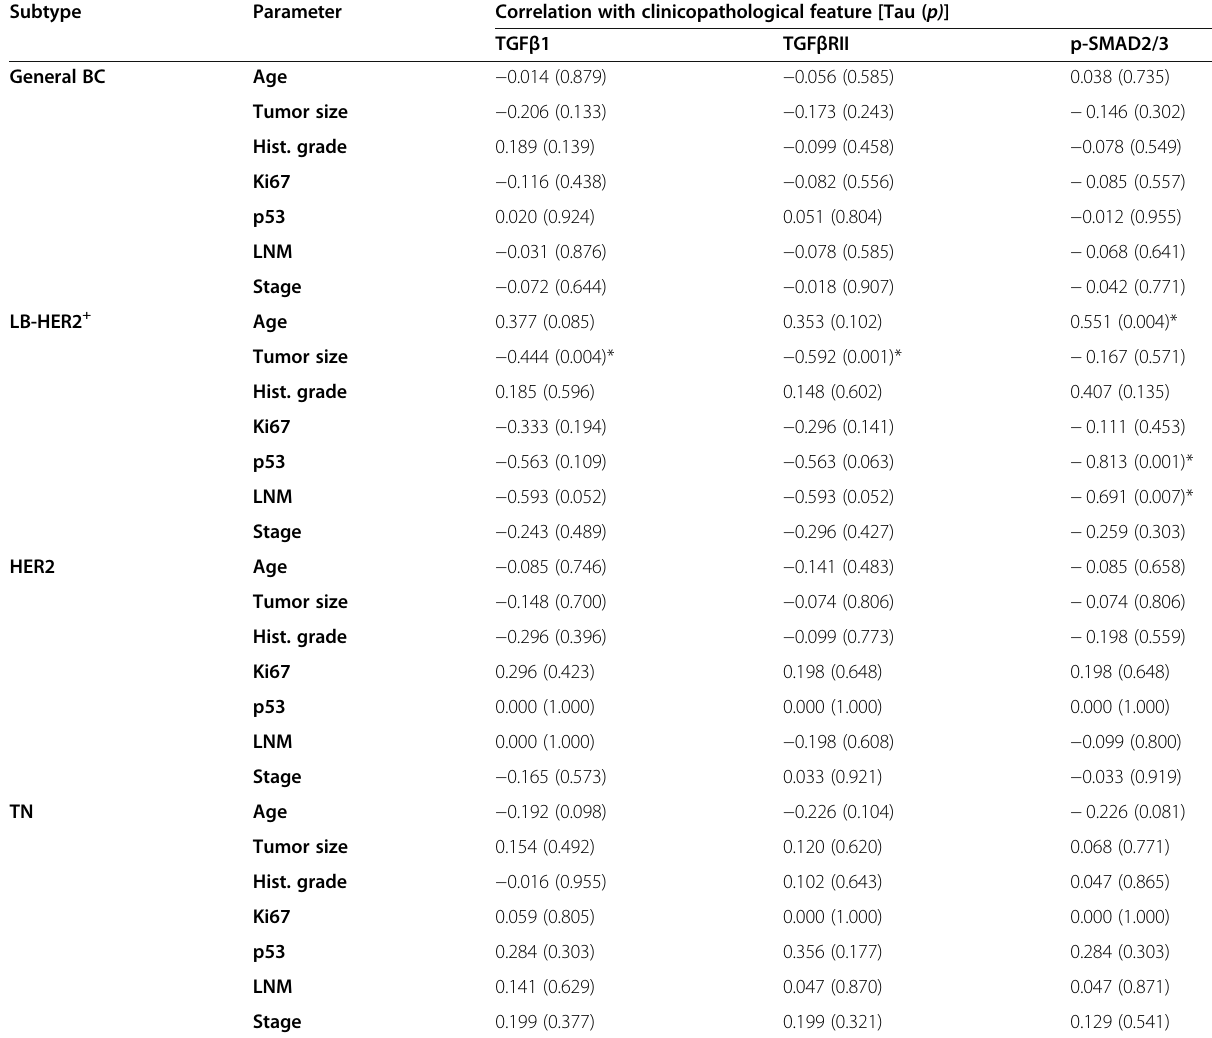
Table 4 Correlation between clinicopathological parameters at diagnosis and intratumor staining for TGF β 1 components according to evaluated breast cancer